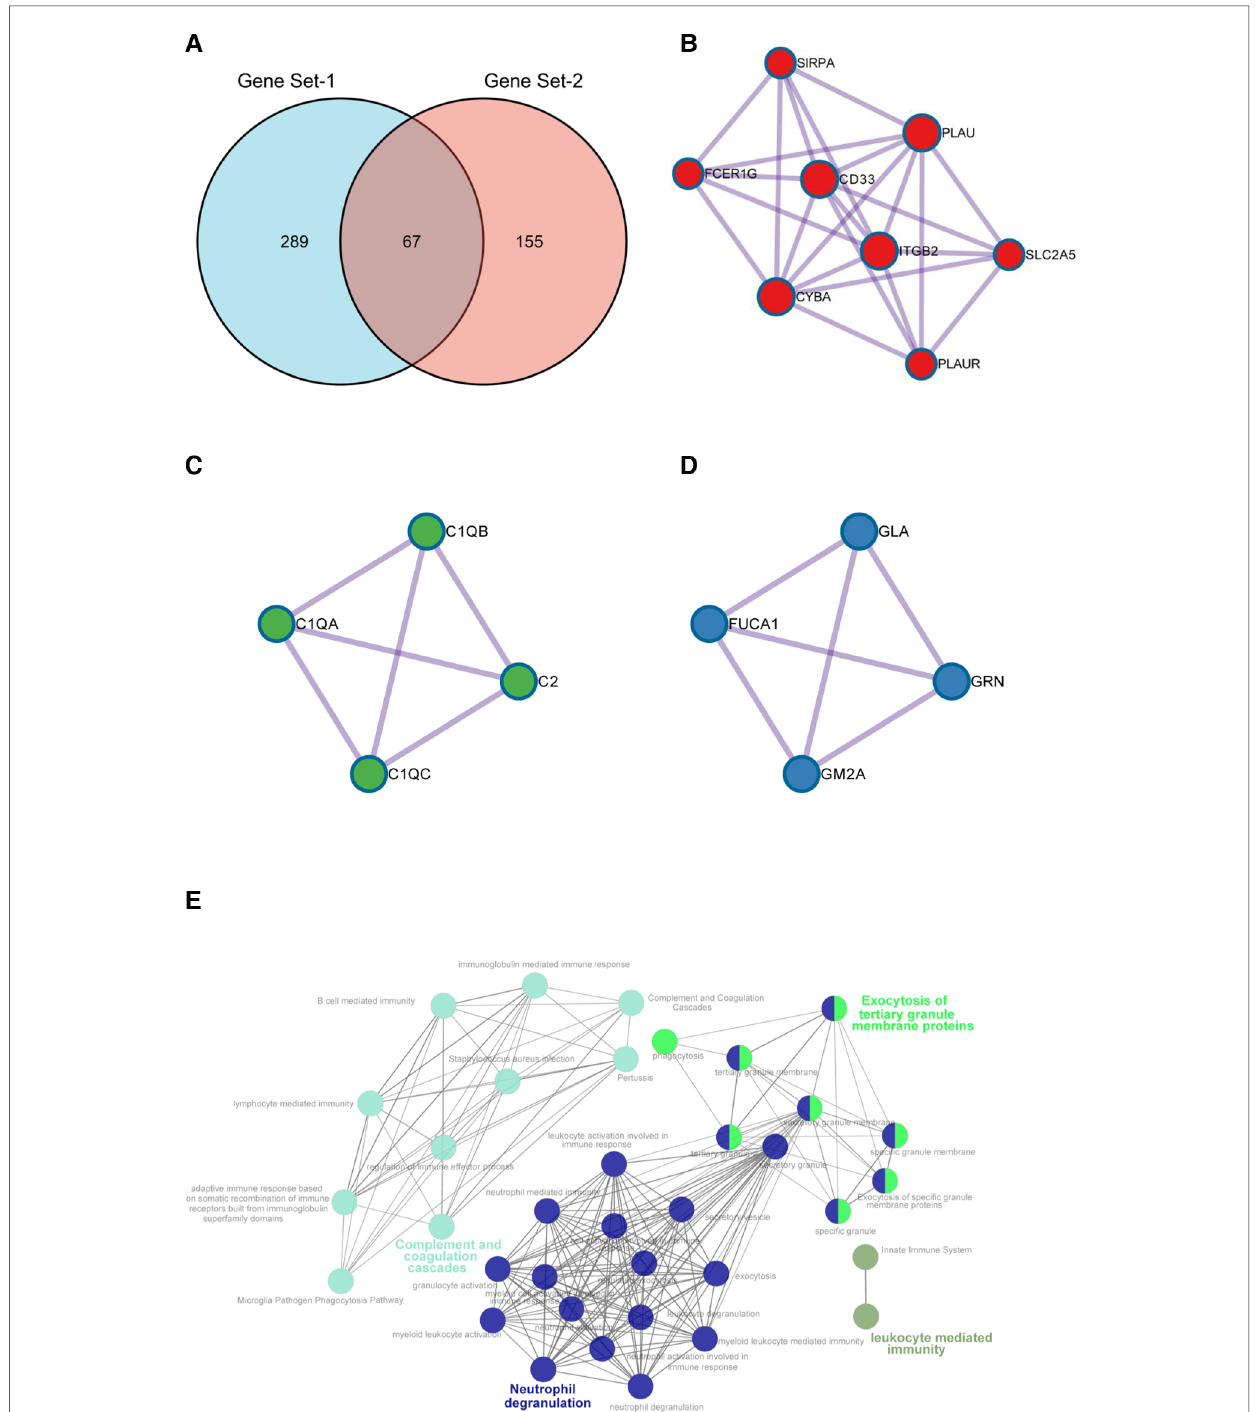
FIGURE 6 Identi fi cation of hub genes. ( A ) Intersection genes of SET1 and SET2. ( B – D ) The three densely connected clusters extracted from shared genes of SET1 and SET2. ( E ) Signal pathway enrichment networks of hub genes constructed by ClueGO. Highlighted words within the network represent the three signi fi cantly enriched